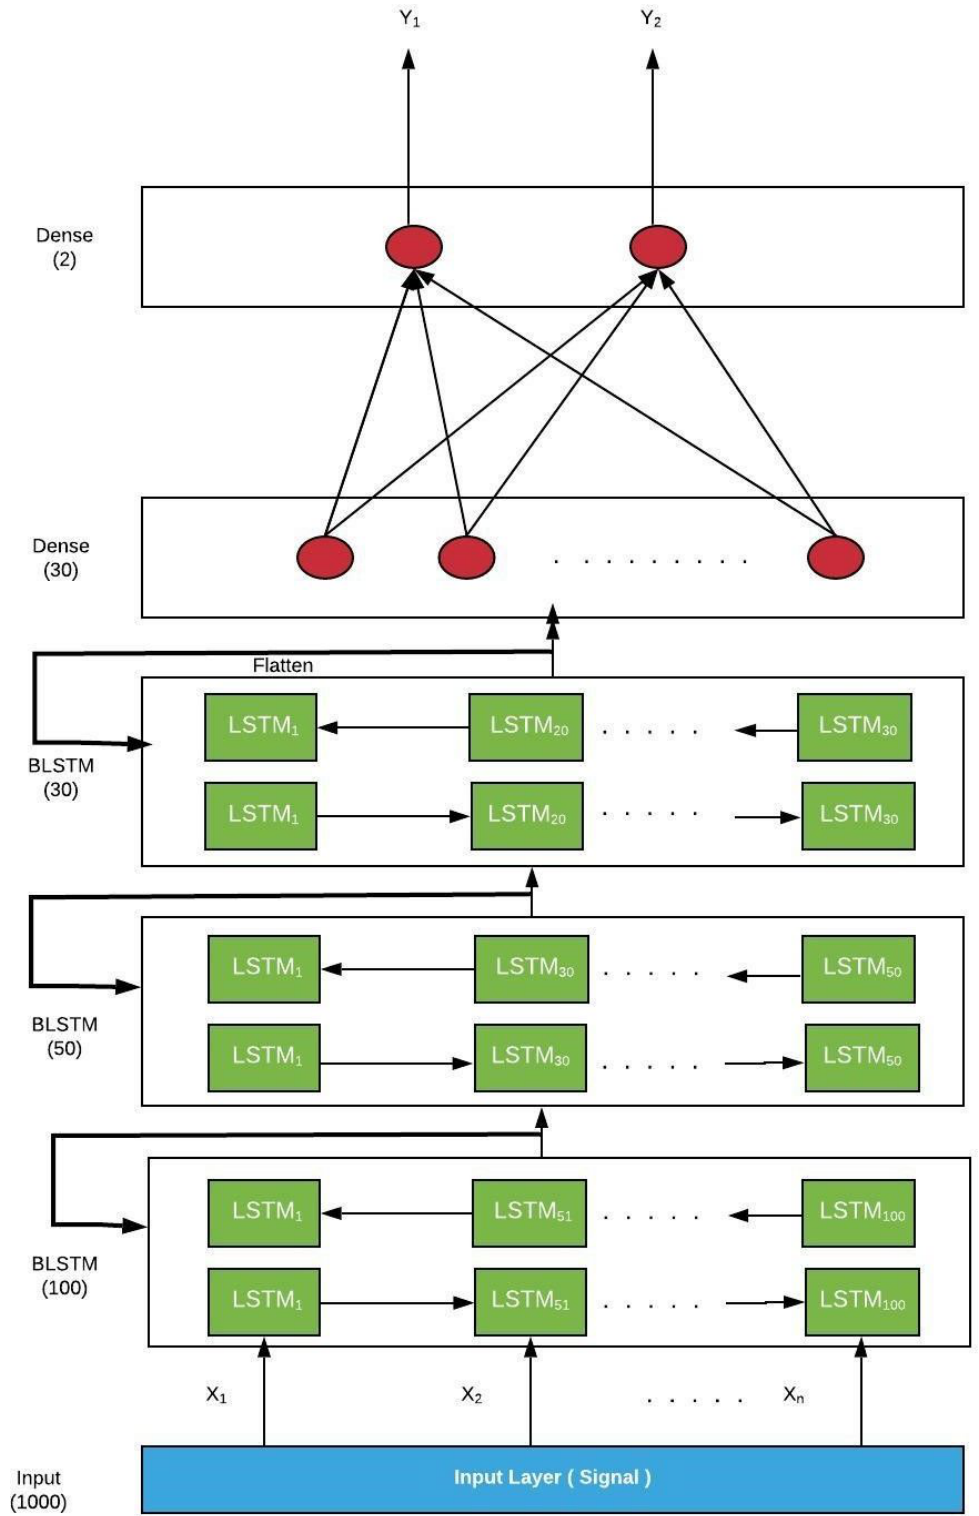
Figure 4: Proposed BLSTM based model for classification of gearbox health